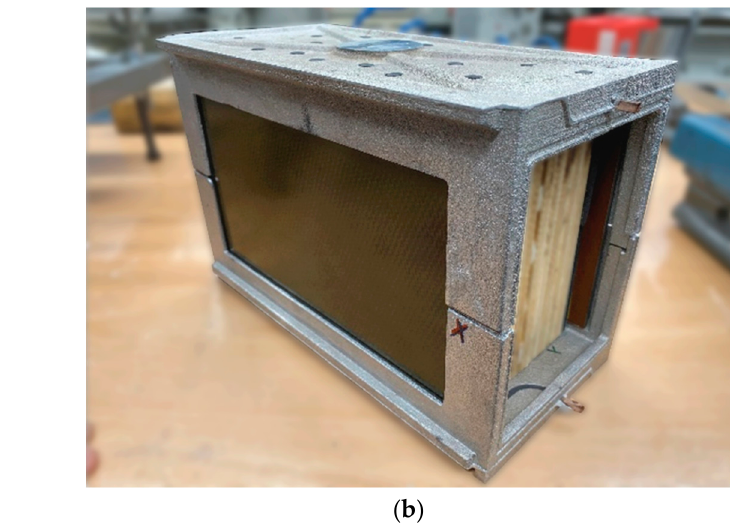
Figure 8. ( a ) Device for inserting the battery cells into the battery module housing halves and joining them and joined battery module housing. ( b ) A dummy battery-cell stack made of wooden elements of the same thickness was used for testing.